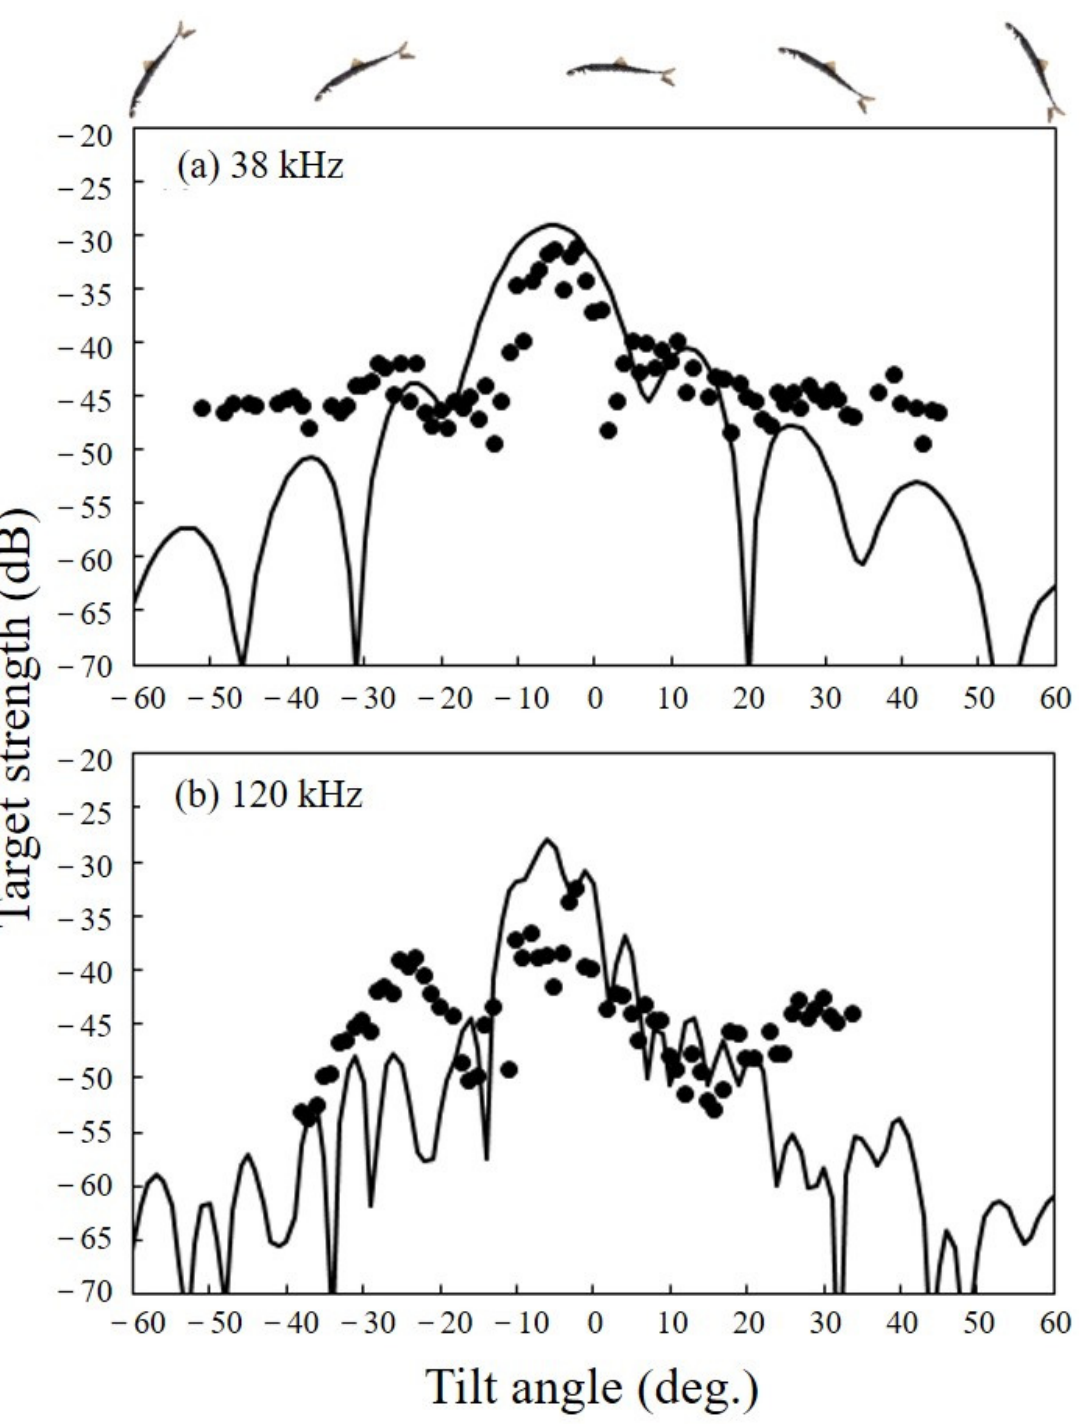
Figure 6. The relationship between Pacific herring TS and tilt angle ( L T : 25.7 cm, swim bladder angle: 6 ◦ ) at three frequencies ( a ) 38 and ( b ) 120 kHz. The points represent the TS from the ex-situ measurements, and the lines represent the TS from the KRM model.